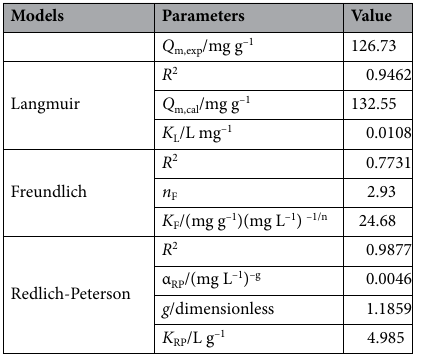
Table 1. Isotherm parameters and their values (pH = 5.0, V = 20 mL, W = 2.0 mg, t = 120 min, temperature = 25 °C, shaking speed = 180 rpm).